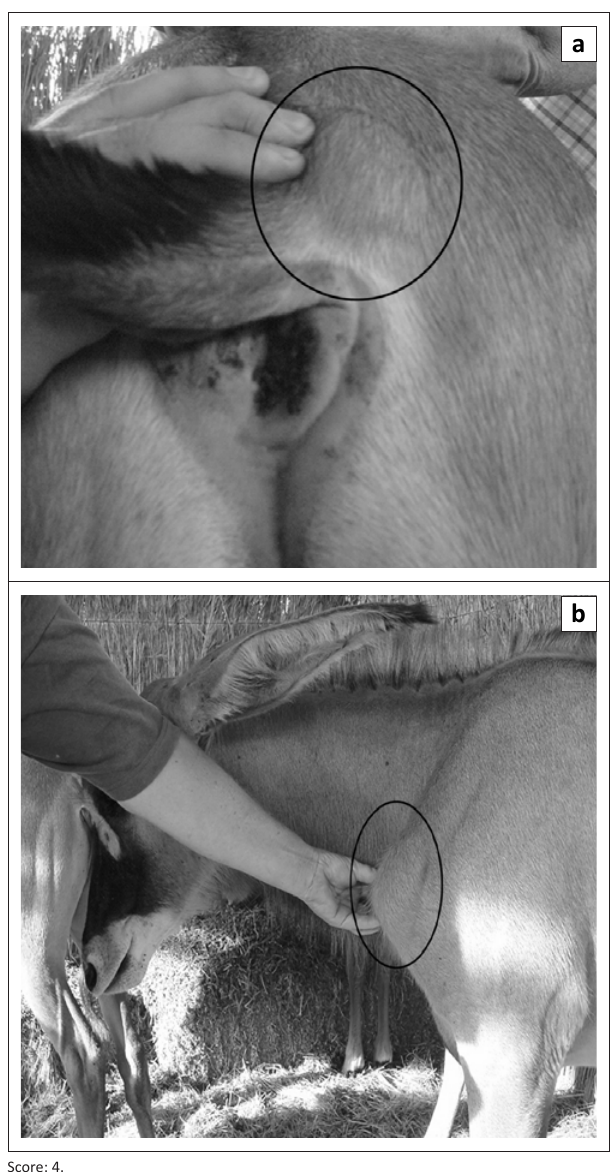
FIGURE 1: Marked (a) anorectal and (b) superficial cervical